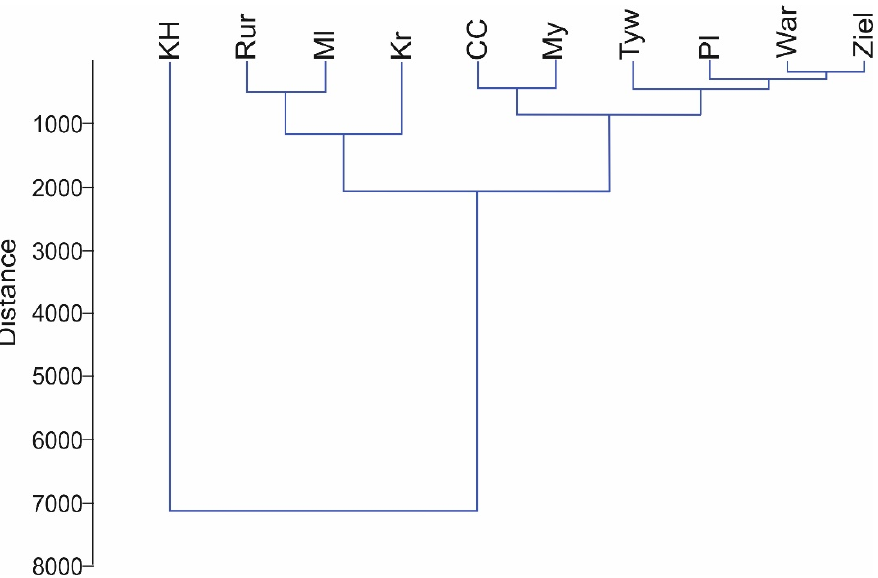
Figure 2. Results of cluster analysis for the studied watercourses based on environmental parame- ters. Abbreviations: P ł onia (Pl), My ś la (My), Tywa (Tyw), Rurzyca (Rur), Wardynka (War), Kana ł Habdzi ń ski (KH), Zielona (Ziel), Czarna Cedron (CC), Kraska (Kr), and Molnica (Ml).